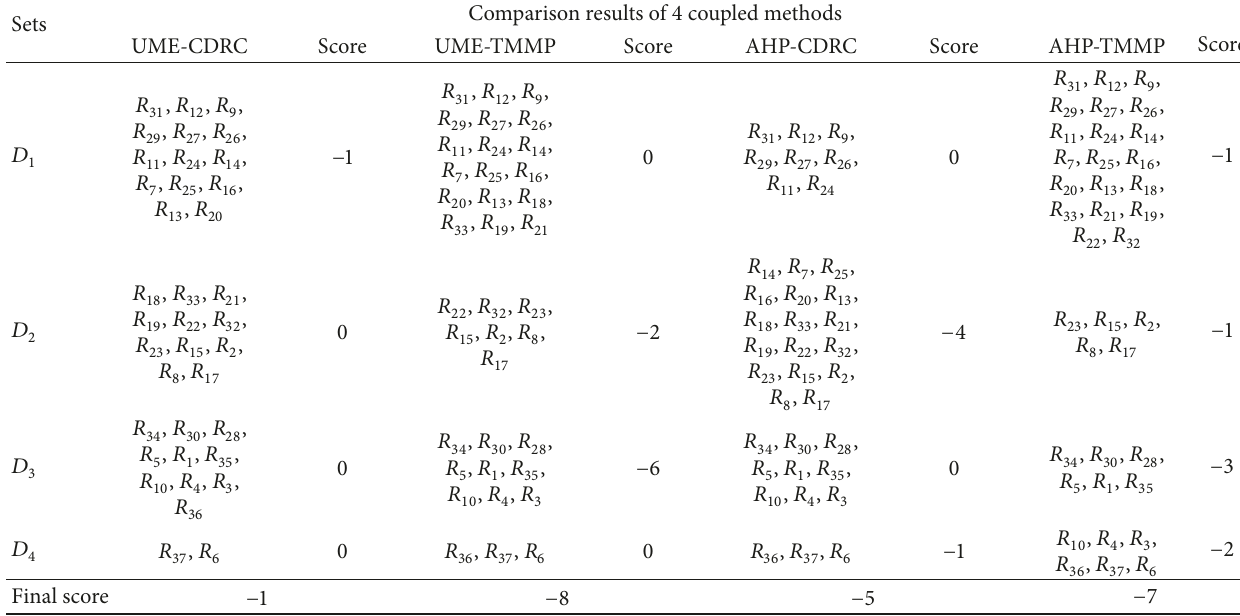
Table 9: The four sets and the corresponding final score values of every coupled